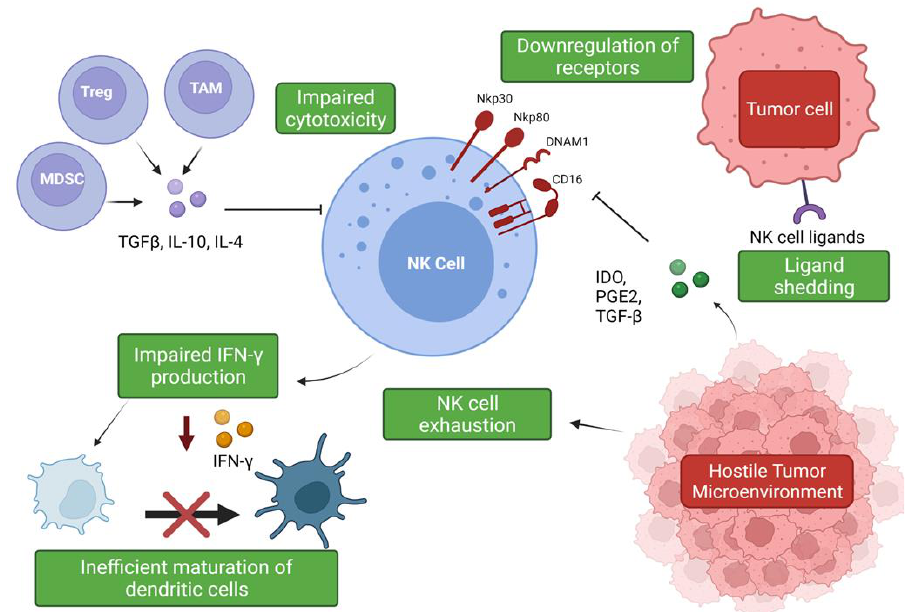
Figure 2. Suppression and evasion of NK cells in the tumor microenvironment. Figure illustrating the various factors that contribute to NK cell dysfunction in the TME and the impact on other immune cells (www.biorender.com, accessed 27 December 2021).